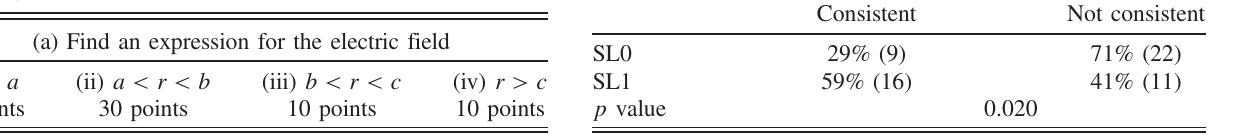
TABLE II. Summary of the scores assigned to each part of the problem.